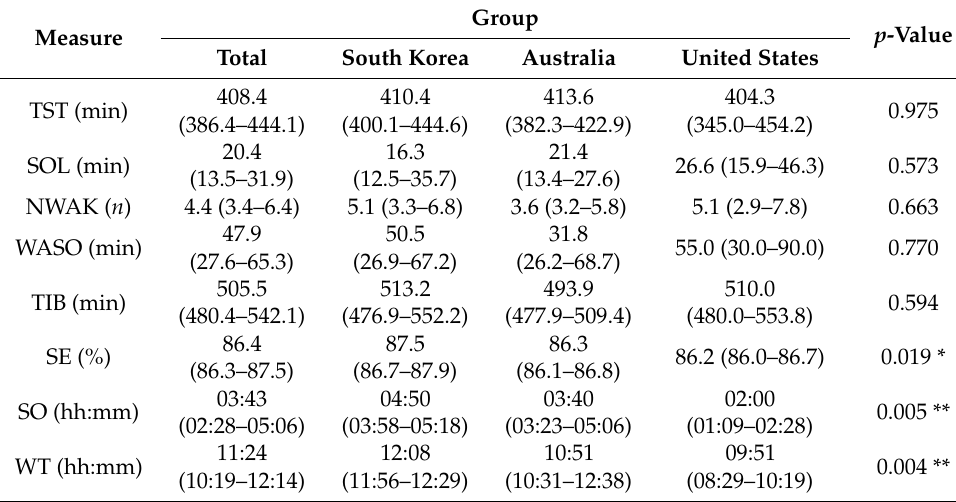
Table 2. Difference between groups in objective sleep data.